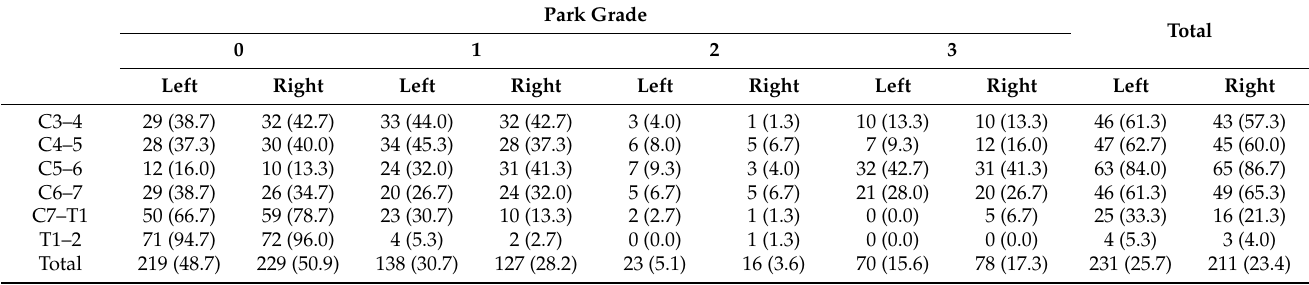
Table 1. Distribution of foraminal stenosis by vertebral